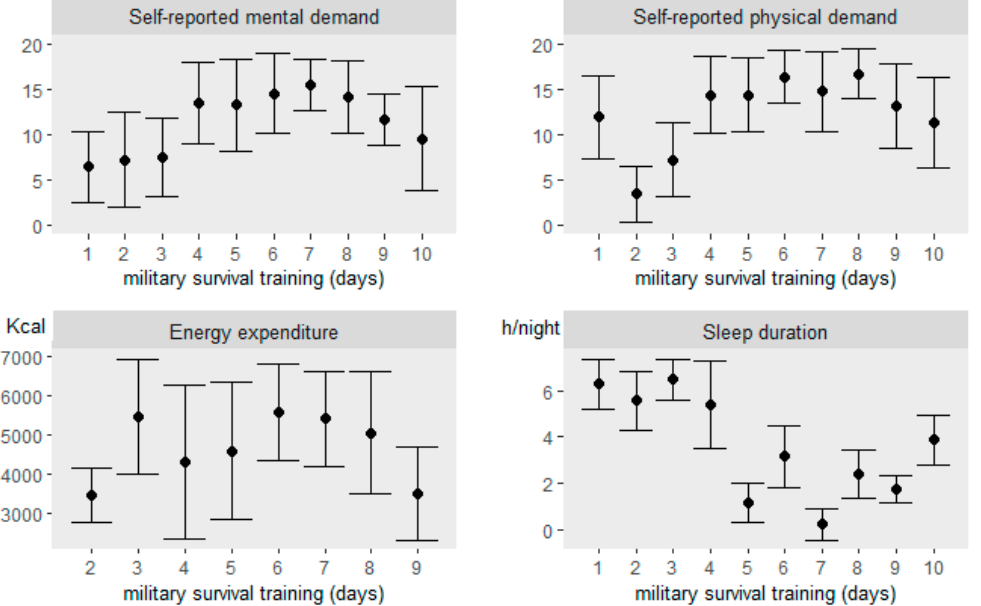
Figure 2. Self-reported physical demand and mental demand assessed by NASA Task Load Index (NASA TLX), and sleep duration, and energy expenditure during military survival